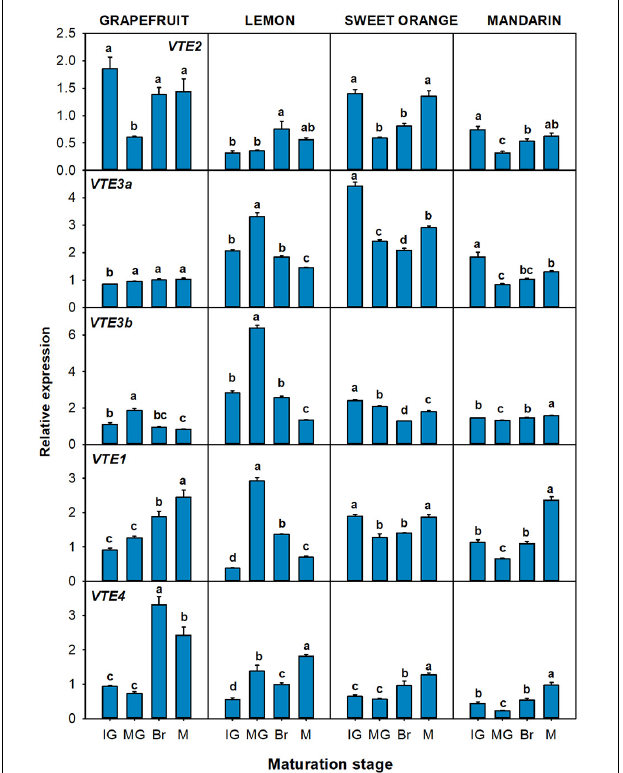
FIGURE 5 | Relative expression of genes of the tocopherol-core pathway in the flavedo during fruit maturation of grapefruit ( C. paradisi ), lemon ( C. limon ), sweet orange ( C. sinensis ), and mandarin ( C. clementine ). The genes analyzed were VTE2 (HPT, homogentisate phytyl transferase), VTE3a and VTE3b (MPBQ-MT, 2-methyl-6-phytyl-1,4-benzoquinol methyltransferase a and b), VTE1 (TC, tocopherol cyclase), and VTE4 ( γ -TMT, γ -tocopherol methyltransferase). Maturation stages correspond to immature green (IG), mature green (MG), breaker (Br), and mature (M). The data are mean ± SE of at least three replicates ( Supplementary Table 11 ). Different letters indicate significant mean differences among maturation stages for each fruit specie (Tukey’s test, p ≤